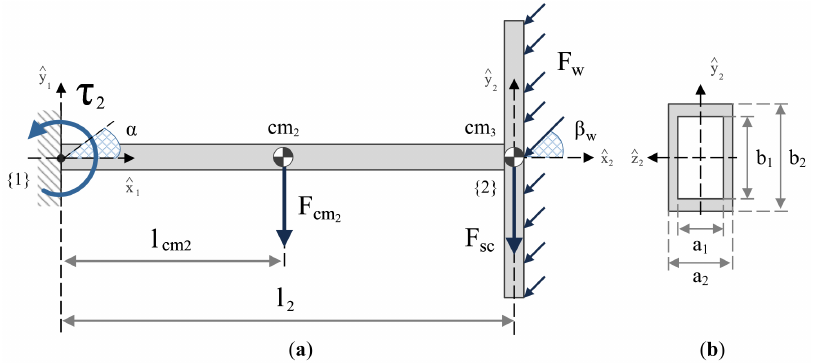
Figure 4. ( a ) Schematic view of applied loads in elevation link and ( b ) cross-sectional area of the beam.